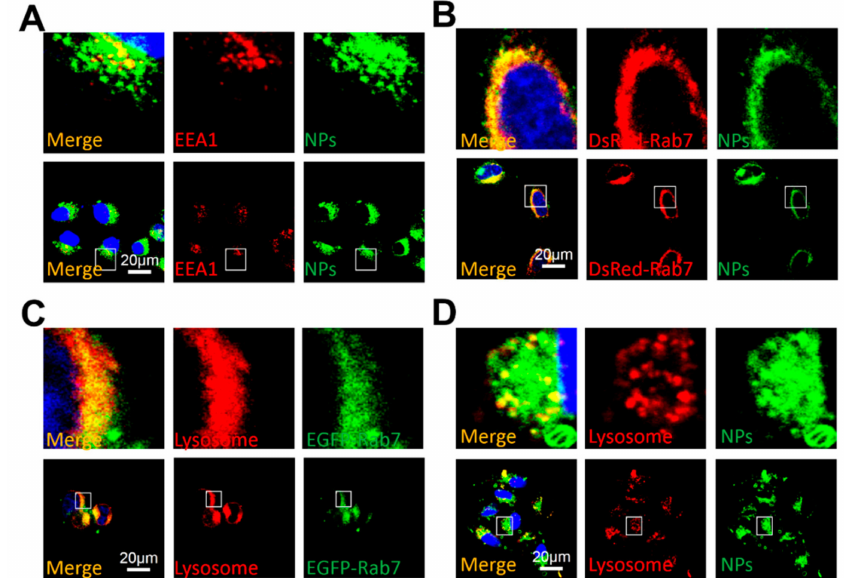
Figure 7. CLSM images of ( A ) MCF-7 cells treated with FITC-labeled NPs (1 mg / mL) for 20 h, in which EEA1 was tested with primary antibody against EEA1, ( B ) DsRed-Rab7 transfected MCF-7 cells treated with FITC-labeled NPs (1 mg / mL) for 20 h, ( C ) EGFP-Rab7 transfected MCF-7 cells treated with Lyso-Tracker Red probes for 1 h, ( D ) MCF-7 cells treated with FITC-labeled NPs (1 mg / mL) for 20 h followed by treated with Lyso-Tracker Red probes for 1 h. ( A – D ) MCF-7 cells were irradiated by NIR (808 nm, 1.5 W / cm 2 , 5 min) at 0.5 h post-treatment. Scale bar: 20 µ m, NPs: FITC /